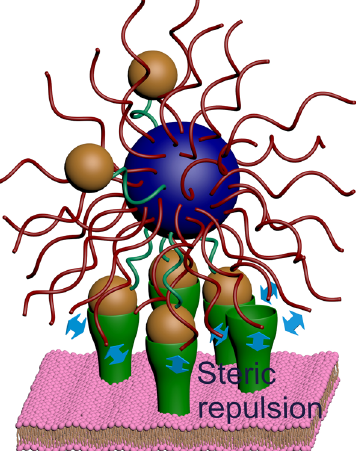
Fig. 1 Schematic representation of our system. A nanoparticle coated with ligands (green tethers and orange spheres) interacts with a receptor-coated surface (green funnels). The attractive interaction arises from the formation of ligand – receptor bonds. The presence of excluded volume interactions (here schematically represented as blue arrows), e.g. due to interaction between the receptor and the nanoparticle coating (red tethers), or between the ligands and the grafting surface of the cell (here shown as a lipid bilayer), provides an additional repulsive interaction. Crucially, the scaling of the two with respect to the number of ligands and receptors is different, giving rise to what we dub here range